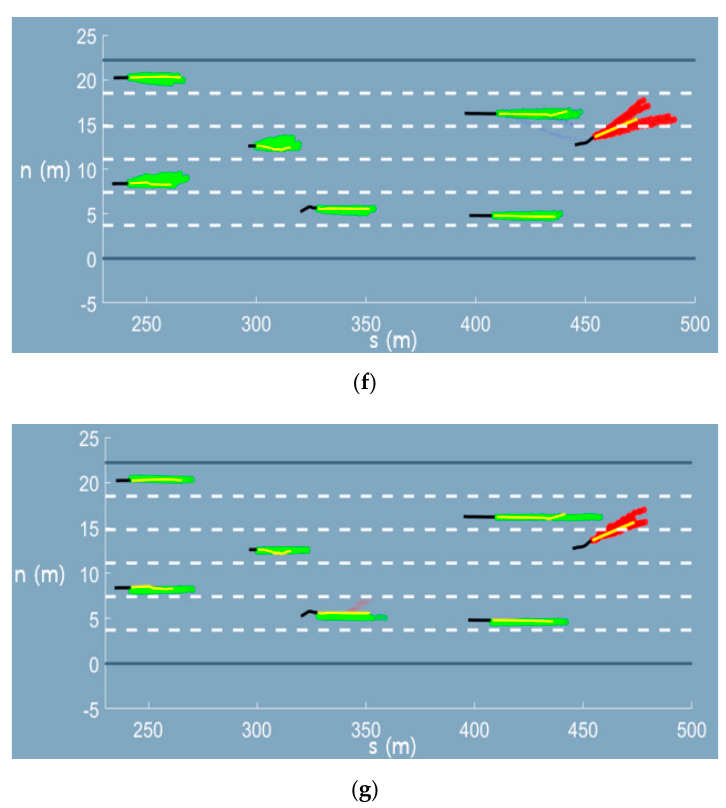
Figure A1. Results of the trajectory prediction network in the local curvilinear coordinates. ( a – g ) are the results of learning by using 5%, 10%, 15%, 20%, 40%, 60%, and 80%, respectively, of the dataset. The bigger and more apparent the marker, the higher the confidence level of the maneuver.